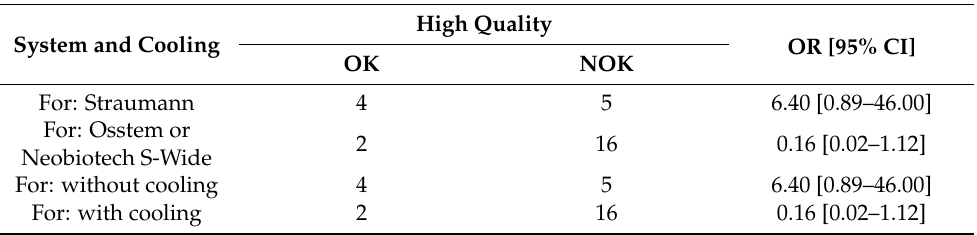
Table 3. The likelihood of a high-quality drill hole surface occurrence in relation to the used system and cooling/non-cooling